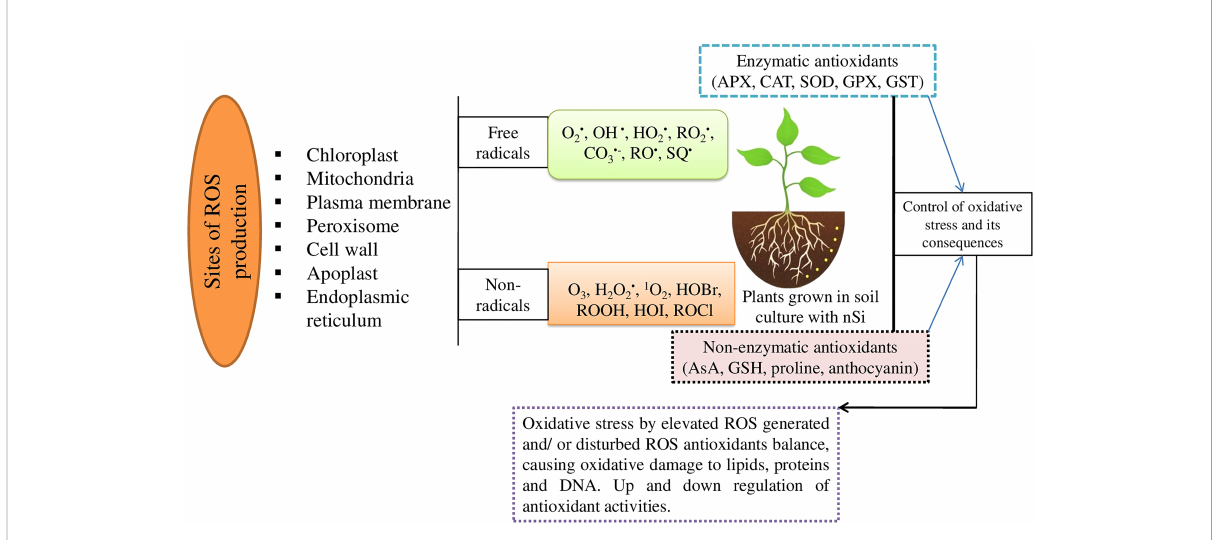
FIGURE 1 Schematic presentation indicating the possible causes for overproduction of ROS that could damage the normal functions of the cells. O · 2 , Superoxide; OH · , hydroxyl; HO · 2 , hydroperoxyl; RO · 2 , peroxyle; CO · − 3 , carbonate; RO · , alkoxyl; SQ · , semiquinone; O 3 , ozone; H 2 O 2 , hydrogen peroxide; 1 O 2 , singlet oxygen; HOBr, hypobromous acid; ROOH, hydroperoxides; HOI, hypoiodous acid; and HOCl, hypochlorous